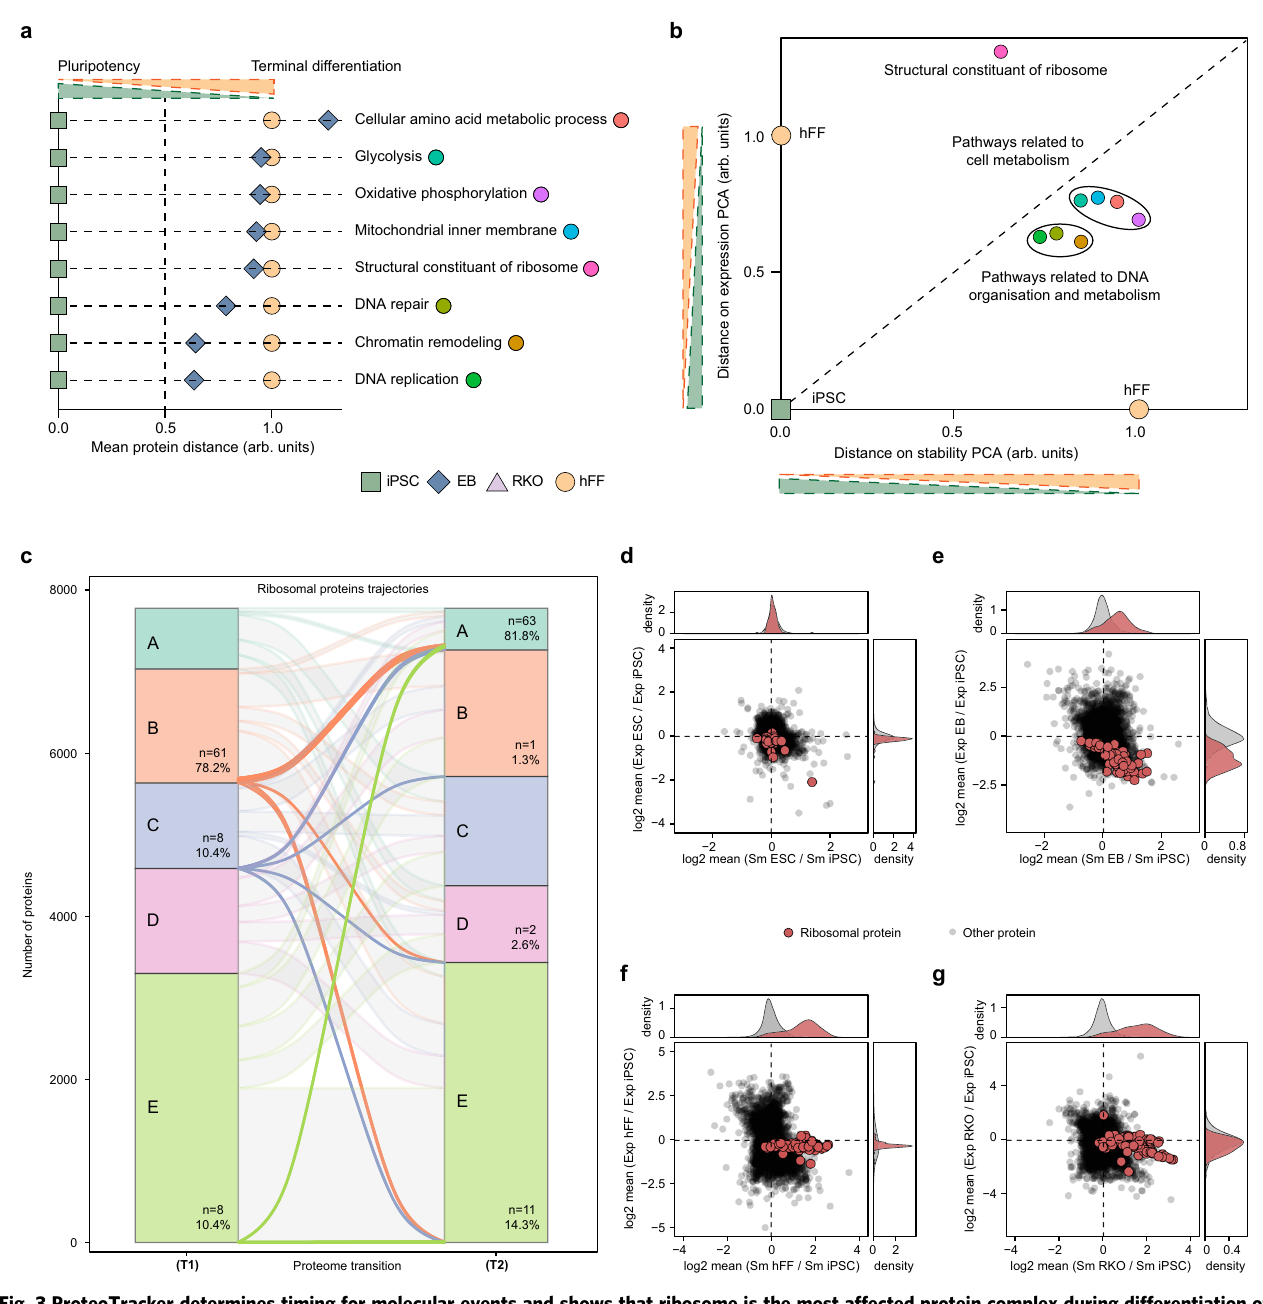
Fig. 3 ProteoTracker determines timing for molecular events and shows that ribosome is the most affected protein complex during differentiation of PSCs. a Differentiation scale determined by the mean distances on T1 and T3 normalized by T3 for selected pathways in iPSC, EB, and hFF. b Differentiation scale determined by distances to iPSC on PCA of the mean Sm and Exp of proteins in each selected pathway in iPSC, hFF, and EB normalized by the distance between hFF and iPSC. c ProteoTracker analysis of ribosomal proteins trajectories in transitions (T1) and (T2). d – g Two-dimensional plots of mean Sm and Exp FCs in H9 ESC, EB, hFF, and RKO against hi12 iPSC. Source data are provided as a Source Data fi than from the changes in intracellular environment. To test this different cell types, we fractionated cell lysates from iPSCs and hypothesis, we performed TPP in cell lysates, in which intracel- RKO cells using a 10 – 50% linear sucrose gradient while recording lular environment affects protein melting behavior to much lesser the absorption at 245 nm. iPSCs demonstrated more abundant degree than in intact cells 12 . Ribosomal proteins had higher 60S subunits (immature ribosomes) with fewer 80S subunits average melting temperatures (Tm) in the hFF lysates than in (mature ribosomes) and polysomes compared to RKO cells iPSC lysates, con fi rming the results in living cells (Supplementary (Fig. 4a, b). The fractions corresponding to the free proteins, 40S Fig. 6c and Supplementary Data 3) and supporting our and 60S ribosomal subunits, mature 80S ribosomes, light poly- hypothesis. somes and heavy polysomes were analyzed by proteomics, which did not reveal signi fi cant differences at either protein or peptide levels (Supplementary Fig. 6f – j and Supplementary Data 2). Thus, iPSCs have lower proportion of functional ribosomes than the higher thermal stability in differentiated cells did not originate RKO . To investigate the difference in ribosomal structure in